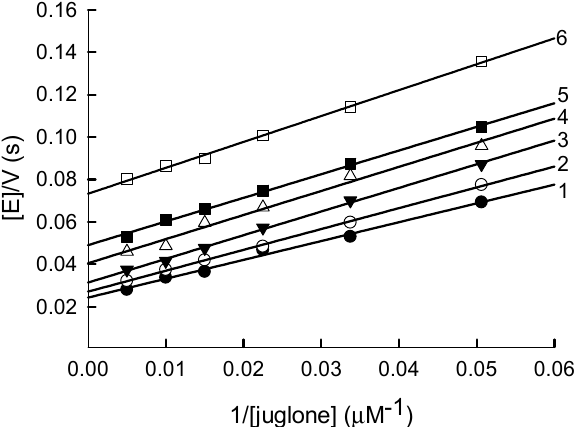
Figure 1. Steady-state kinetics of a reduction of juglone by NADPH catalyzed by Pf FNR. NADPH concentrations: 200 µM (1), 150 µM (2), 100 µM (3), 75 µM (4), 50 µM (5) and 25 µM (6).